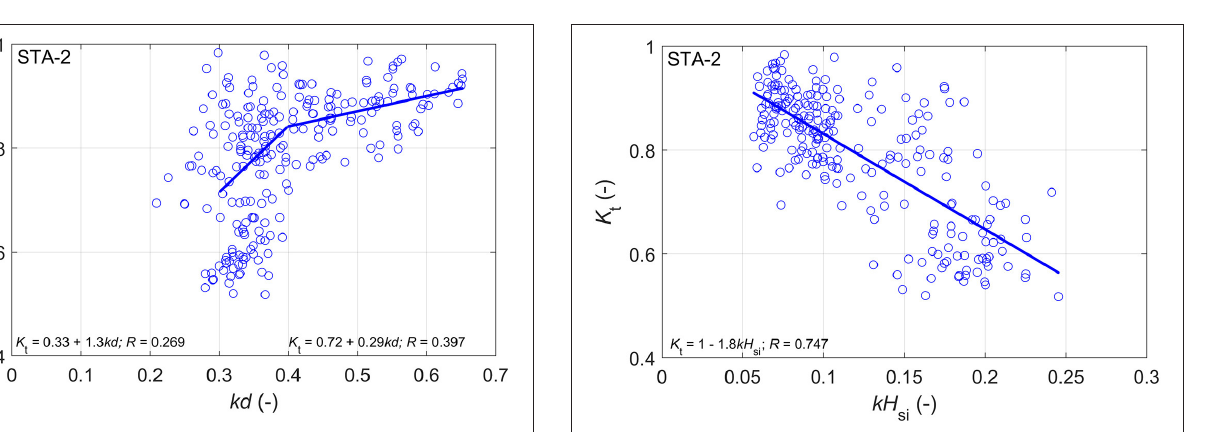
FIGURE 6 | The relationship between the wave transmission coefficient K t and the relative water depth kd .